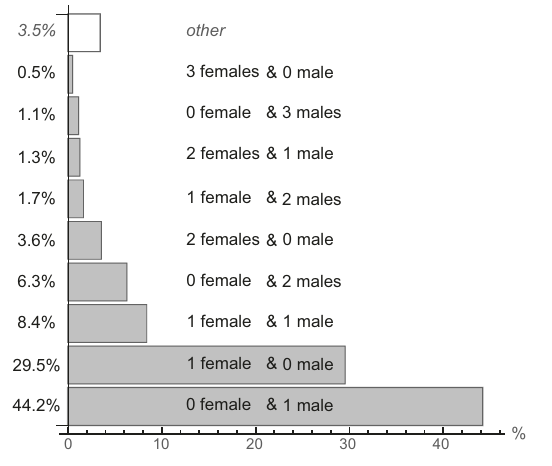
Fig. 5 Combinations of character genders. Each bar represents a gender combination among the most common ones over the period (2014 – 2019). HUMANITIES AND SOCIAL SCIENCES COMMUNICATIONS| (2021) 8:137